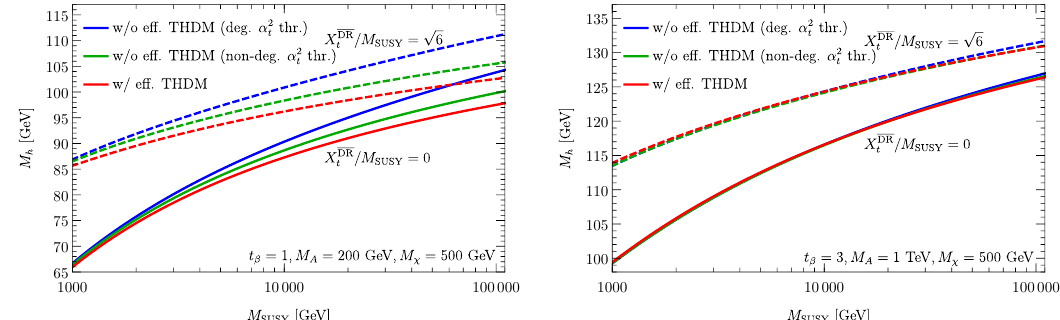
p =M SUSY = 0 (solid) and X DR =M SUSY = 6 t t ) threshold correction (blue) t ) threshold correction (green) | are compared with the results t